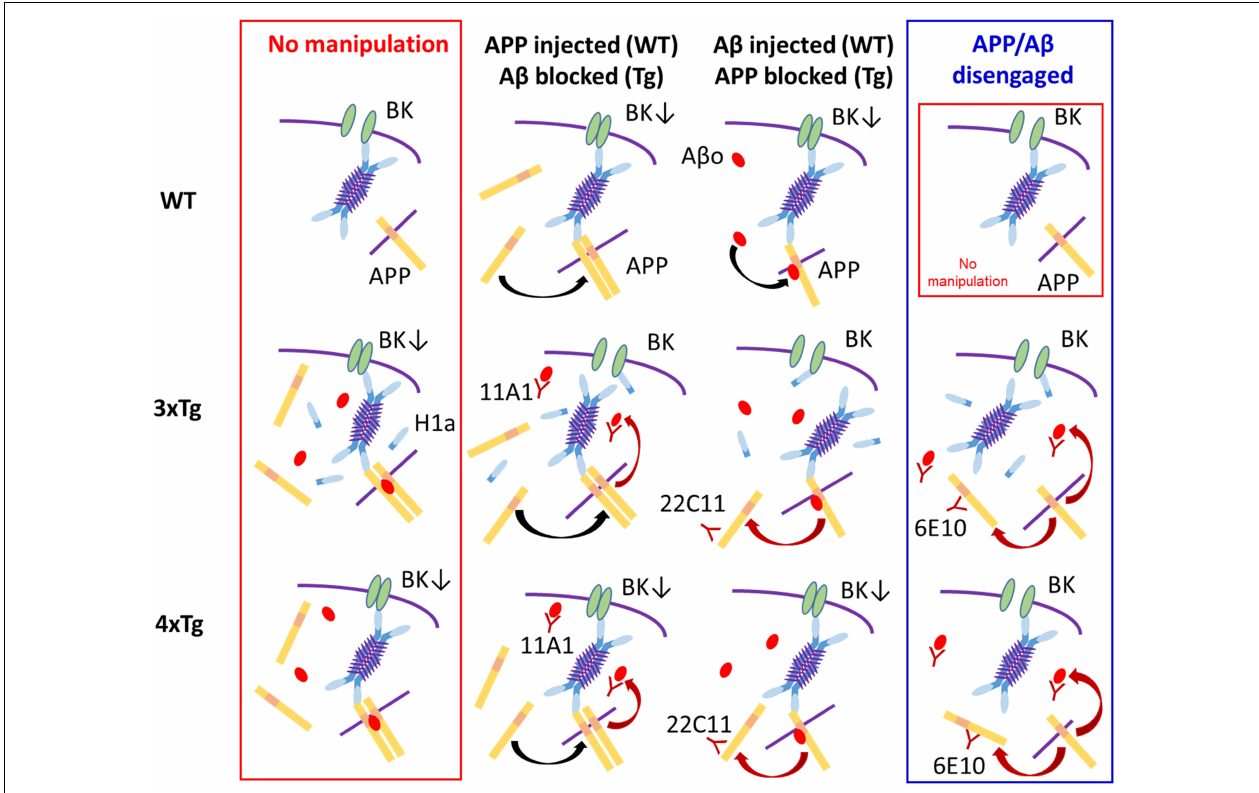
FIGURE 6 | A tentative scheme illustrating the proposed mode of BK channel suppression and our interpretation based on the present experiments. The blue 4-armed structure represents the 4-mer of long Homers, which is considered to be the most stable form (Hayashi et al., 2009). Very short purple lines on the 4-mer signify the coiled-coil parts, which bind 4 long Homers to one another. The sky blue parts of the 4-mer represent the EVH domain, which binds to BK channel, APP and others. The isolated sky blue bar is the icon for Homer1a, which includes the EVH domain but lacks the coiled-coil domain and therefore competes with the 4-mer over BK channel. The yellow bars signify APP embedded in cytosolic or endoplasmic membrane (symbolized by the purple line) or floating in the free form. APPs tend to constitute dimers with or without the aid of A β oligomer (A β o; the red oval). The downward arrow in “BK ↓ ” symbolizes BK channel suppression (BK channel; green ellipses). (1) Top Row (WT neuron): Leftmost , In WT neurons, APP physiologically exists and embedded into endoplasmic or plasma membrane, but contacts the Homer 4-mer too weakly to persuade the 4-mer to suppress BK channel. Second left , With APP injected, excessive free APP dimerizes (black arched arrow) and strongly urges the 4-mer to block BK channels. Second right , With A β injected, A β o binds to APP (black arched arrow). The A β -bound APP has a higher affinity and the 4-mer is more strongly persuaded to block BK channel. Rightmost , Identical to that in Leftmost. (2) Middle Row (3xTg neuron): Leftmost , In 3xTg neurons, the presence of abundant intracellular A β and APP urges formation of APP dimer-A β complex, strongly affecting the 4-mer and thereby blocking BK channels. Since 3xTg neurons are hyperexcitable, the activity-dependent expression of Homer1a continues but cannot reverse BK channel blockade in the presence of the APP dimer-A β complex. Second left , Because of APP overexpression, APP dimerizes (black arched arrow). With the anti-A β antibody 11A1 injected, the APP dimer-A β complex is disrupted (red arched arrow), weakening the potency of the 4-mer to block BK channels. The weakened 4-mer is disengaged by Homer1a, thereby relieving BK channel suppression. Second right , With the anti-APP antibody 22C11 injected, reduction of membrane-bound APP disrupts dimer formation (red arched arrow). However, A β is still excessive, and the A β –APP monomer binding is maintained. Overall, the suppression of the 4-mer on BK channel is weakened by dissolving the APP dimer-A β complex but kept effective by the A β –APP monomer binding. However, Homer1a is the competitor against the 4-mer over BK channel, and plays the decisive role, reversing BK channel blockade. Rightmost , With 6E10 that blocks both APP and A β , the 4-mer is weakened similarly (two red arrows) and disengaged from BK channel blockade by Homer1a. (3) Bottom Row (4xTg neuron): In 4xTg neurons, the states of the 4-mer, the APP dimer-A β complex, APP dimer formation, the A β –APP binding and BK channel blockade are the same as in 3xTg neuron. The effects of 22C11 and 11A1 are also the same, but the only difference resides in the absence of Homer1a. Therefore, the weakened 4-mer is not disengaged by Homer1a but continues to block BK channel (middle 2 panels). With 6E10 injected (rightmost), however, the weakening of the 4-mer would advance one-step further because of the double blockade of APP and A β , so that the 4-mer is disengaged even without Homer1a, thereby relieving BK channel. (4) Rightmost Column: APP monomer on its own cannot lead to BK channel suppression. (5) Leftmost Column: All neurons remain as they naturally are, with nothing injected. In 3xTg and 4xTg, affluence in both APP and A β o forms the A β o–APP dimer complex, which suppresses BK channel so strongly that Homer1a in the 3xTg neuron cannot rescue it. In 4xTg, the lack of Homer1a precludes the Homer1a-mediated rescue from the beginning. (6) Middle two columns: APP dimer or A β o–APP monomer complex suppresses BK channels to a lesser extent than the A β o–APP dimer complex. In 3xTg neurons, the relatively weaker complexes cannot overcome the counteraction of Homer1a. In WT and 4xTg neurons, where Homer1a is lacking or expressed little, even the relatively weaker complexes are sufficiently strong to suppress BK channels.